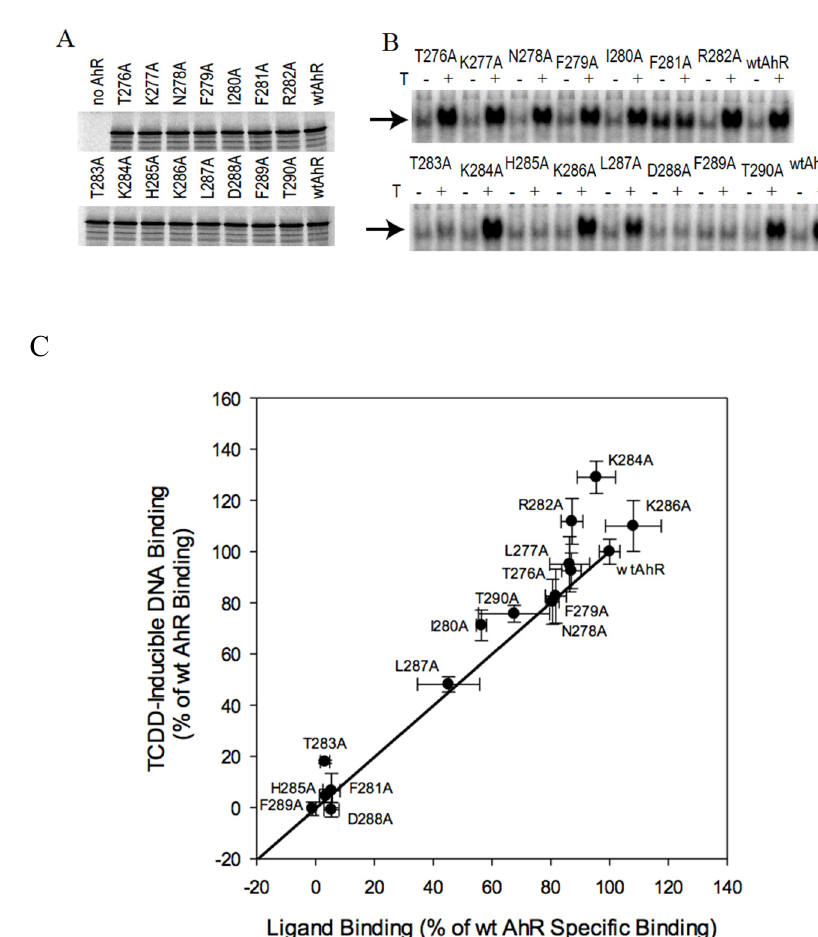
Figure 2. E ff ects of mutagenesis of amino acids 276–290 of the AhR PASB on 2,3,7,8-tetrachlorodibenzo-p-dioxin (TCDD)-inducible AhR transformation / DNA binding and [ 3 H]TCDD specific binding. ( A ) In vitro protein expression of AhR mutants. Indicated AhR constructs were synthesized in vitro in the presence of [ 35 S]-methionine and resolved by SDS-PAGE and autoradiography. ( B ) In vitro synthesized wild type (wt) or mutant AhRs and ARNT were diluted at 1:1:8 ( v / v / v ) ratio (AhR:ARNT:bu ff er), transformed in the presence of 10 nM TCDD (T) or 1% DMSO ( v / v ) for 3 h, and protein-DNA complexes analyzed by gel retardation analysis. A representative gel is shown and the specific protein-DNA complex is indicated with an arrow. ( C ) Comparison of ligand binding and ligand-dependent DNA binding for wt and mutant AhRs. [ 3 H]TCDD binding to the in vitro synthesized AhR in the presence ARNT, diluted at 1:1:8 ( v / v / v ) ratio (AhR:ARNT:bu ff er), was analyzed by hydroxyapatite assay following 1 h of incubation at room temperature in the presence of 10 nM [ 3 H]TCDD. Values were normalized to those obtained with unprogrammed lysate (non-specific binding control) and plotted vs corresponding values of the TCDD-inducible protein-DNA complex for each AhR from gel retardation experiments (panel A). Values represent the mean ± standard deviation of triplicate independent binding reactions. Data points overlapping with the trend line would indicate a proportional change in ligand binding and DNA binding for the indicated mutant AhR (i.e., unchanged transformation e ffi ciency; see text). Note: F281A was constitutively active in DNA binding (2B); however, since it demonstrated no ligand-dependent increase in DNA binding, the resulting ligand-dependent change in DNA binding was low and similar to that of inactive AhRs (2B). Results presented are representative of at least three independent experiments.